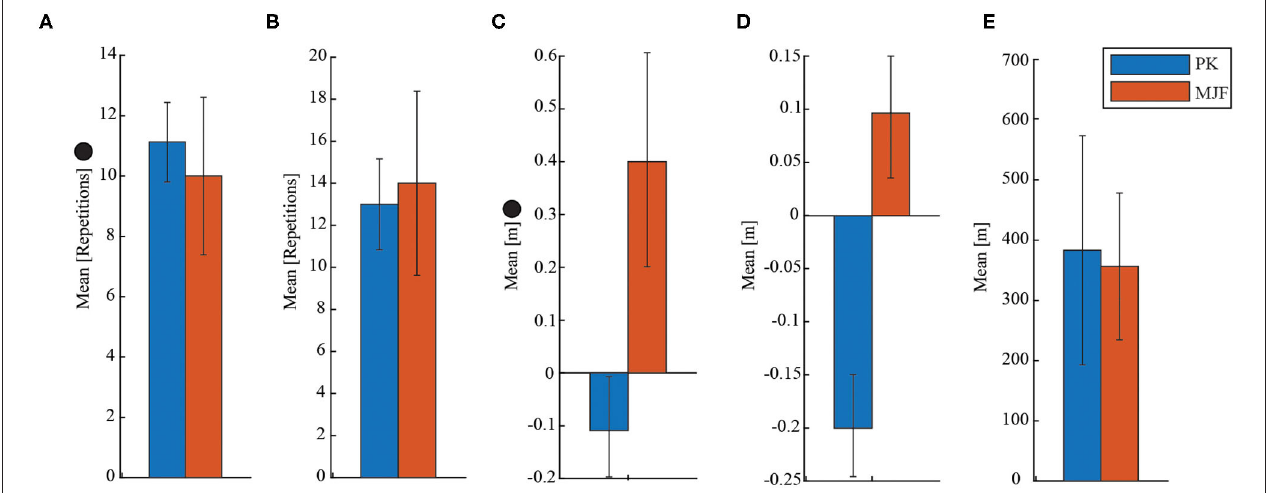
FIGURE 5 | Illustration of the results obtained for the SFT. • indicates that there were significant differences between the groups evaluated. (A) Sit to Stand Test (SST). (B) Arm Curl Test (ACT). (C) Chair Sit and Reach Test (CSRT). (D) Back Scratch Test (BST). (E) Six Minutes Walking Test (6MWT).